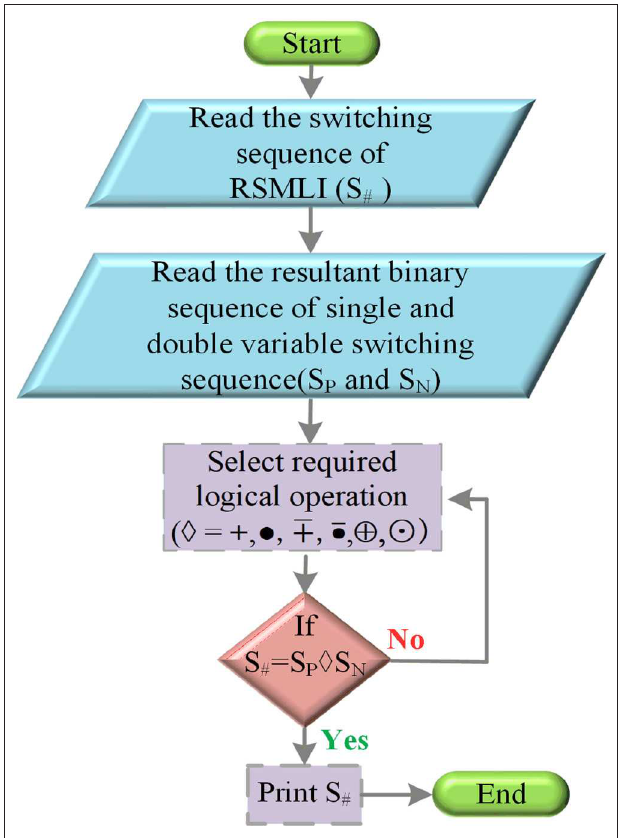
FIGURE 6 | Flowchart for selecting the required logical operation for switching sequence.